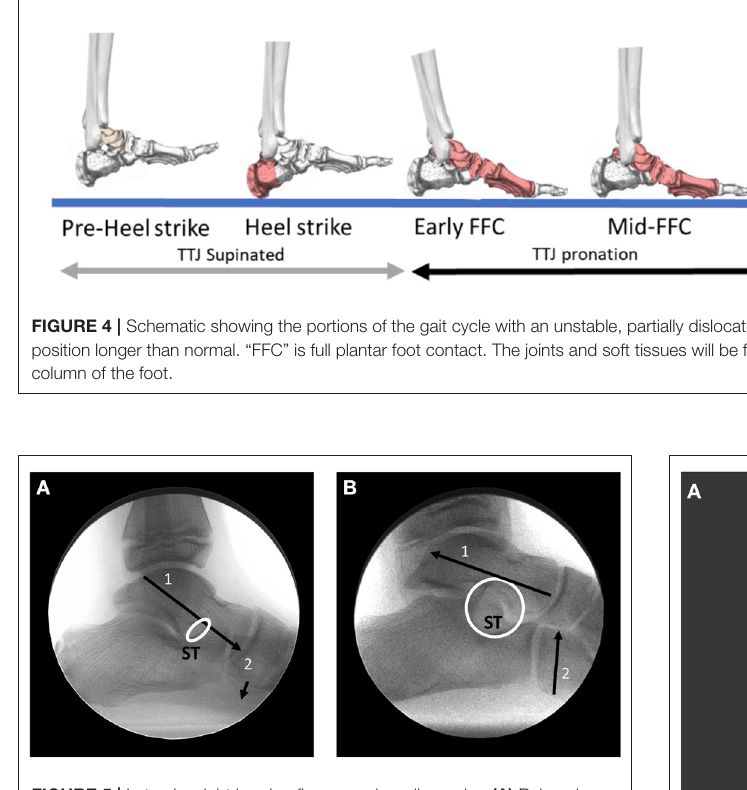
FIGURE 5 | Lateral weight bearing fluoroscopic radiographs. (A) Relaxed stance position. The talus has partially dislocated on the calcaneus (1). The sinus tarsi (ST) is obliterated and the navicular has dropped (2). (B) The same foot with the articular facets of the talus repositioned on the calcaneus (1). Sinus tarsi (ST) is re-opened and the navicular is elevated (2). FIGURE 6 | Posterior 3-dimensional weightbearing computed tomography of